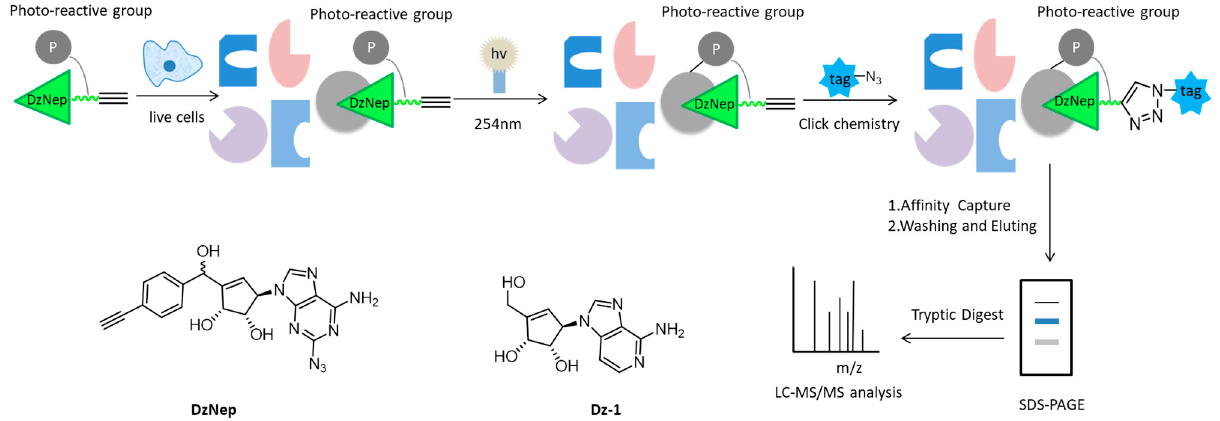
Figure 3. Overall workflow of the cell-based proteome profiling approach followed by large-scale pull-down/LC-MS/MS for identification of potential cellular targets of DzNep using affinity-based probe DZ-1.